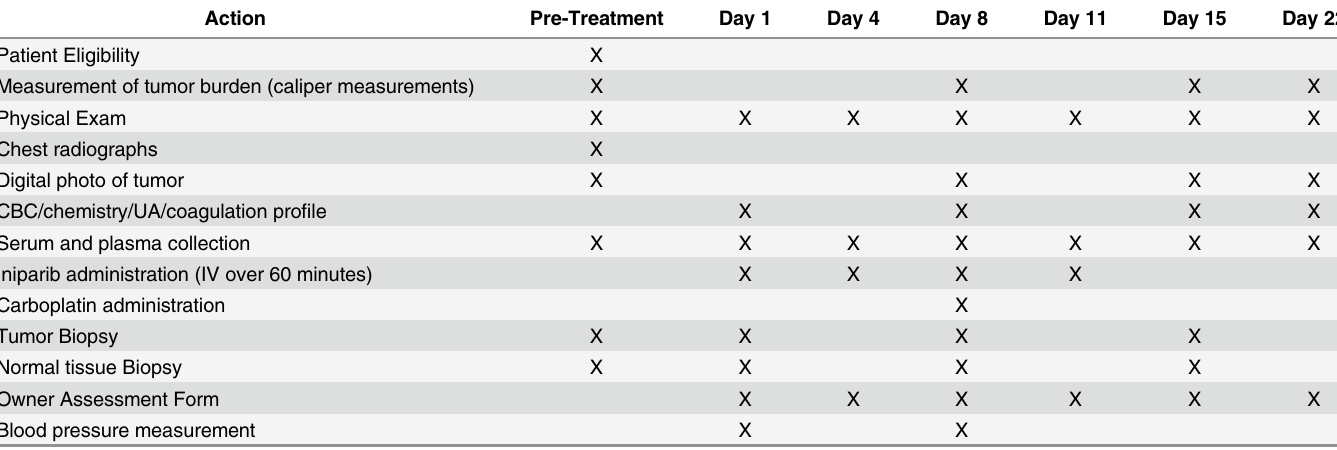
Table 1. Schedule of patient evaluations and study procedures.